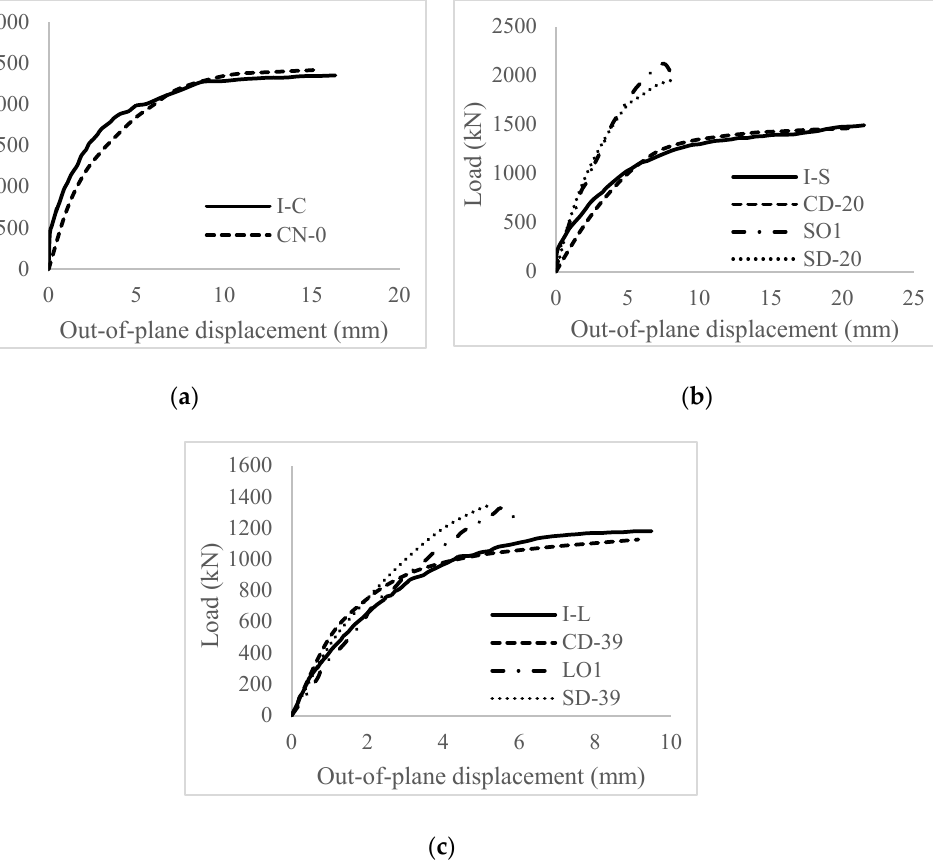
Figure 7. Load versus out-of-plane displacement curves of FEA models and test specimens with: ( a ) no opening; ( b ) small openings; ( c ) large openings.